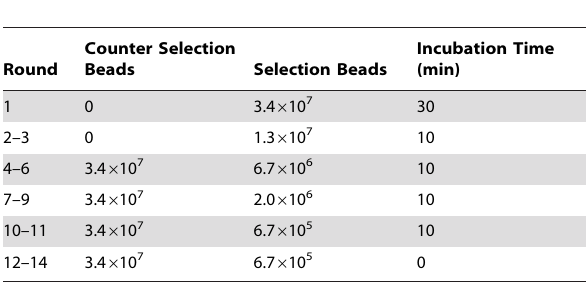
Table 2. Values for the number of beads and incubation times used in each